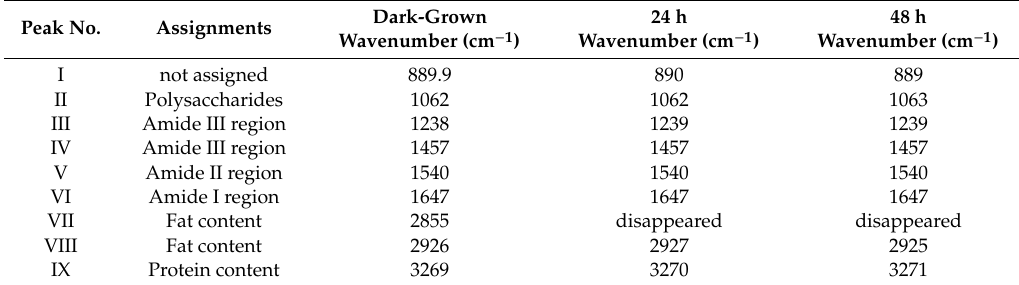
Table 2. Main bands in the FTIR spectra and their assignments of dark-grown chia microgreens and microgreens after exposure to light for 24 and 48 h.